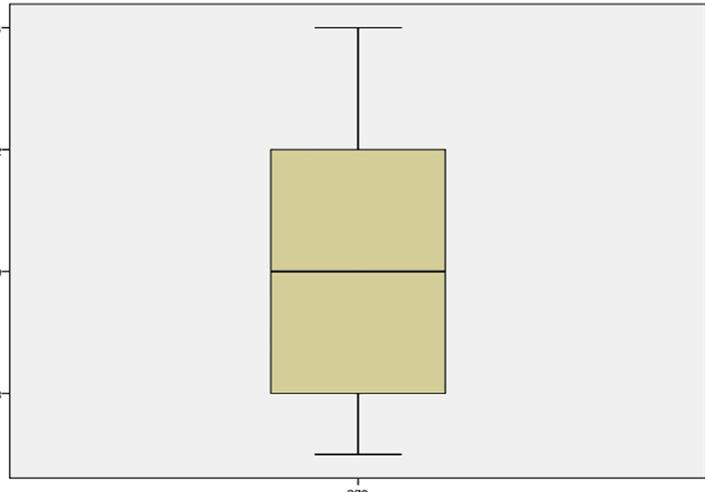
Fig 2. A box/whisker plot showing the age distribution of the study